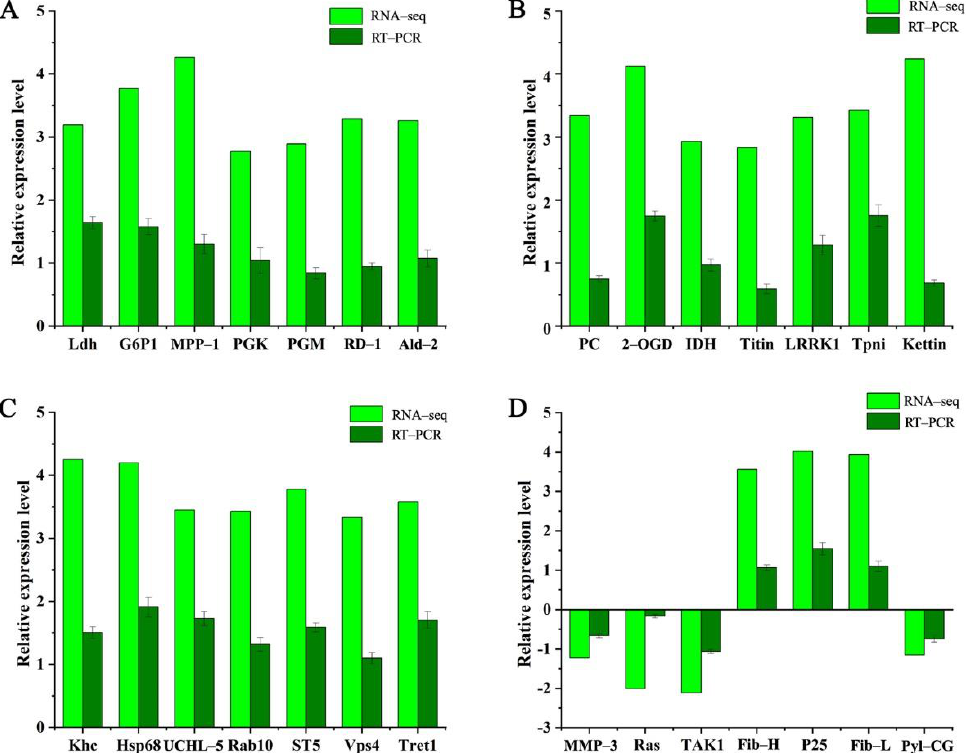
Figure 4. The qRT-PCR validation for DEGs expression after exposure to H 2 S. DGEs related to the glycolysis pathway ( A ), the TCA cycle ( B ), endocytosis ( C ), and inflammation and silk protein synthesis ( D ) were analyzed. The full names of abbreviations of genes were listed in Table